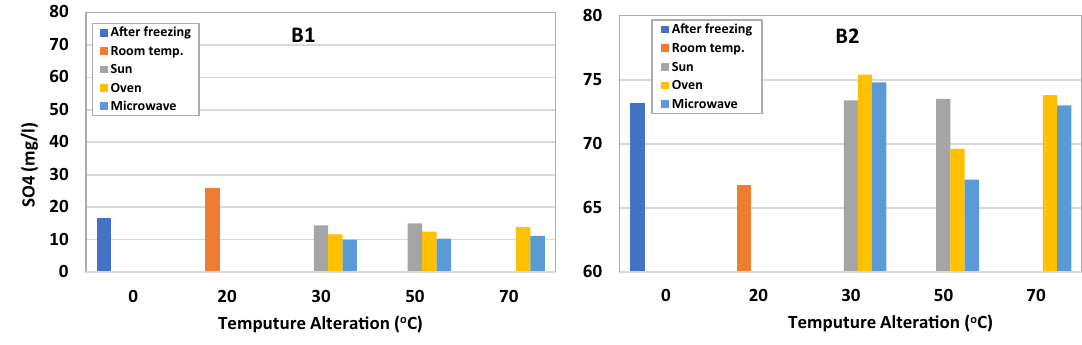
Fig. 7 Sulfate concentrations at different heating degrees for brands B1 and B2